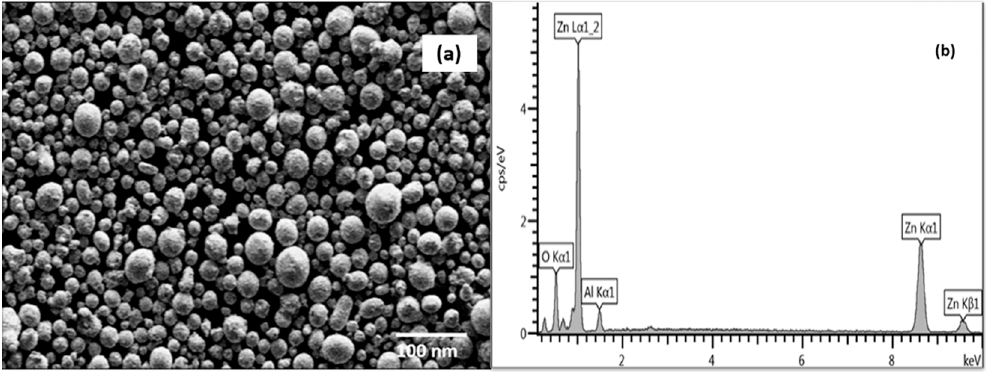
Figure 14. ( a ) SEM micrographs of a) AZO1 particles synthesized at 10 kW. Spherically shaped morphology with no cluster formation is observed for all the compositions of AZO samples. ( b ) EDS spectrum for AZO1 synthesized at 10 kW. Reproduced with permission from Ref. [61]; published by Springer Nature, 2019.